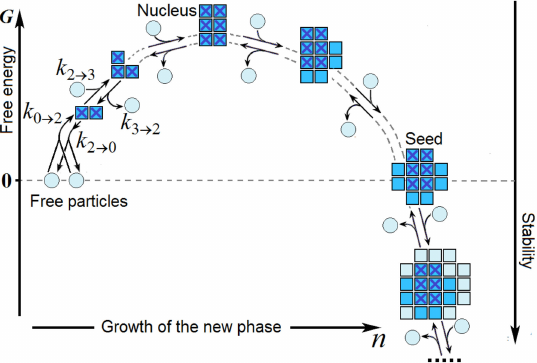
Figure 2. A sketch of the crystal formation from free particles: The reaction is initiated by the sticking together of a few particles in a configuration that allows further growth of the ordered phase. Rather than the initiation, the new phase appearance rate is determined by the formation of a “nucleus” of this phase (shown by crosses) that corresponds to the activation barrier, i.e., has the maximal free energy G and, thus, the minimal stability during this process. k 0 → 2 , k 2 → 3 , . . . are the rate constants of the initiation and further growth of the new phase; . . . , k 3 → 2 , k 2 → 0 are the rate constants of the new phase’s decrease and subsequent disappearance (see text). For other designations, see Figure